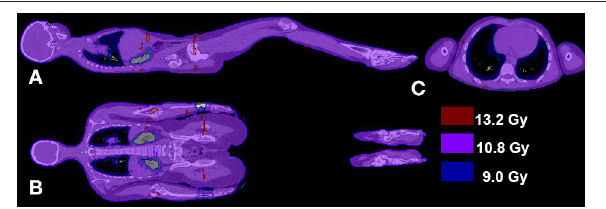
FIGURE 3 | CT-planned VMAT total body irradiation technique dose distribution. Computed tomography (CT)-planned volumetric-modulated arc therapy (VMAT) total body irradiation technique dose distribution for a 12Gy prescription dose in the sagittal (A) , coronal (B) , and transversal view (C) . The isofill-depicted dose levels are 75% (9Gy; blue), 90% (10.8Gy; purple), and 110% (13.2Gy; red) of the prescription